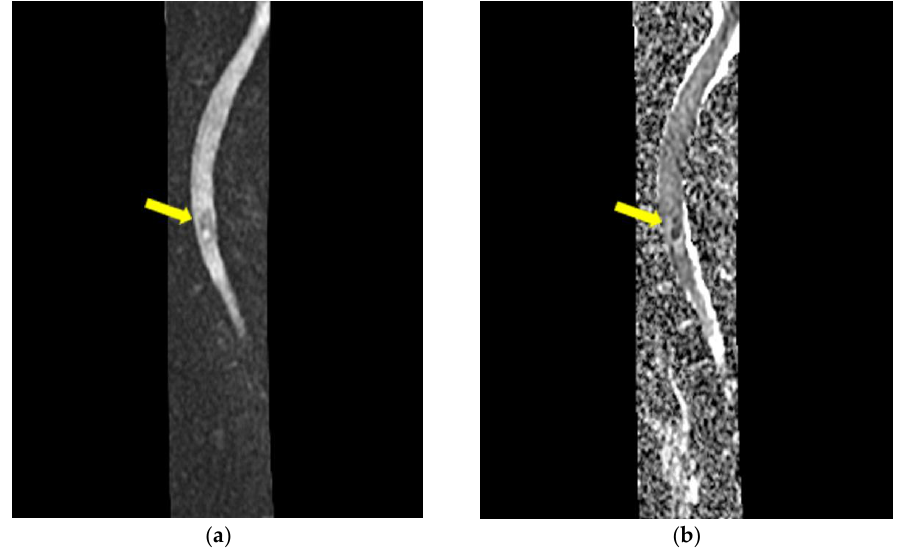
Figure 5. MRI of the cervical spine—sagittal DWI ( a ) and ADC map ( b ): the lesion is hyperintense on DWI, and restricted diffusion is illustrated on ADC map. The yellow arrow indicates the expan- sive cystic intramedullary process.